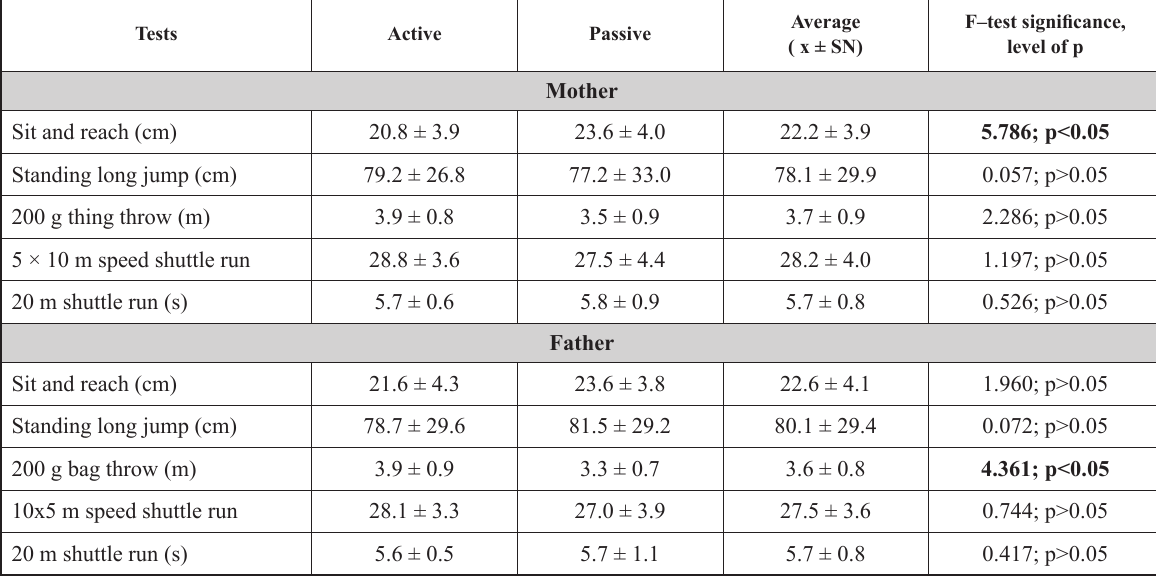
Table 3. Relationships between children’s physical fitness and their parents’ physical activity